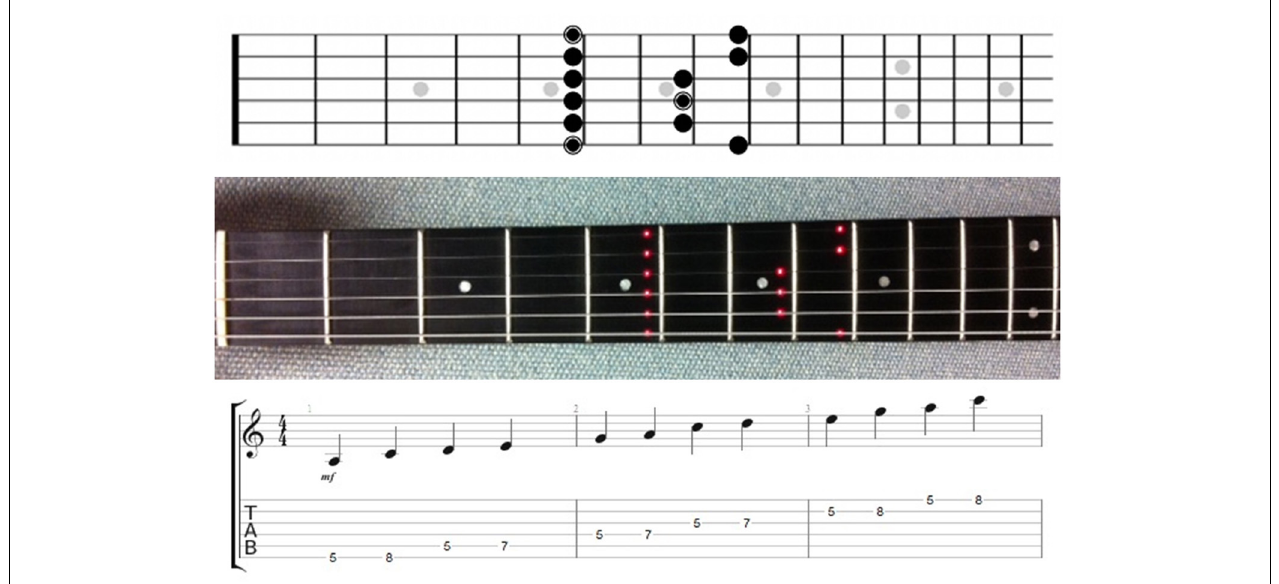
FIGURE 3 | A minor pentatonic scale diagram (top) and Fretlight ® guitar (middle) used in Experiments 1 and 2. Circled notes on the diagram are the roots (i.e., A in three different octaves), but this was not mentioned to participants. For illustration purposes only, we have also